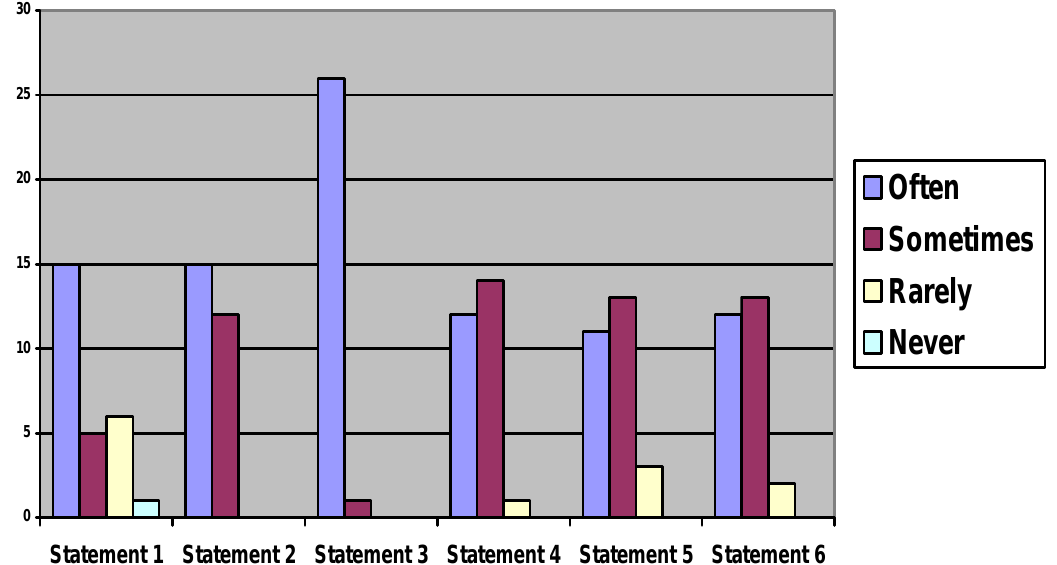
Figure 7. Teacher Survey given after implementation of posting and communicating daily learning